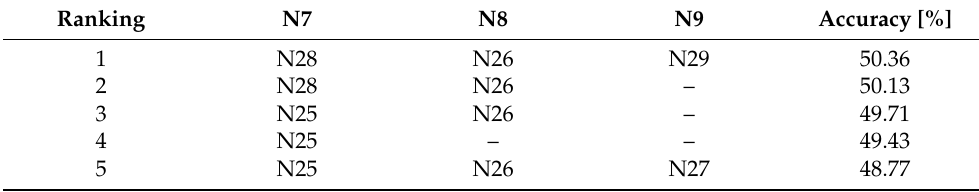
Table 16. Top five recognition accuracies after changing processing